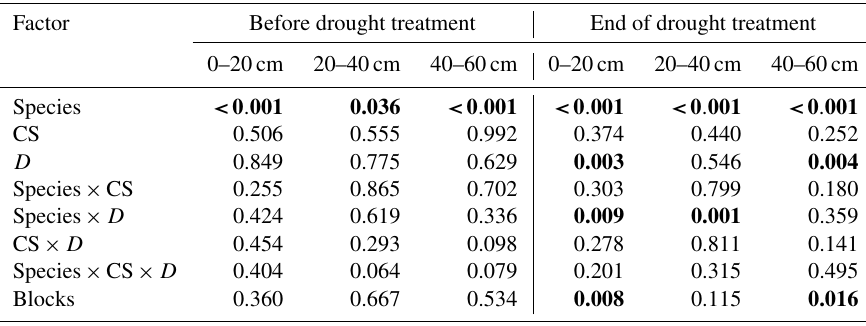
Table 4. Effects of the species (df = 1), cropping system (CS, df = 3), drought treatment ( D , df = 1), and interaction (species × CS, df = 3; species × D , df = 1; CS × D, df = 3; species × CS × D , df = 3) on the median proportional contribution from different soil depths to water uptake (MPC) of pea and barley before the drought treatment on 7 May and at the end of the treatment on 25 June 2018 tested by linear mixed models ( p values are